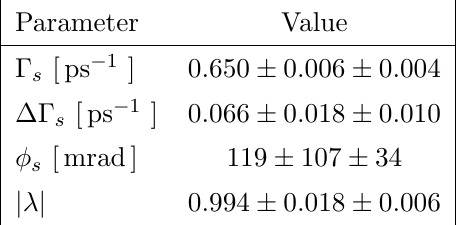
decay observables in the high m KK s